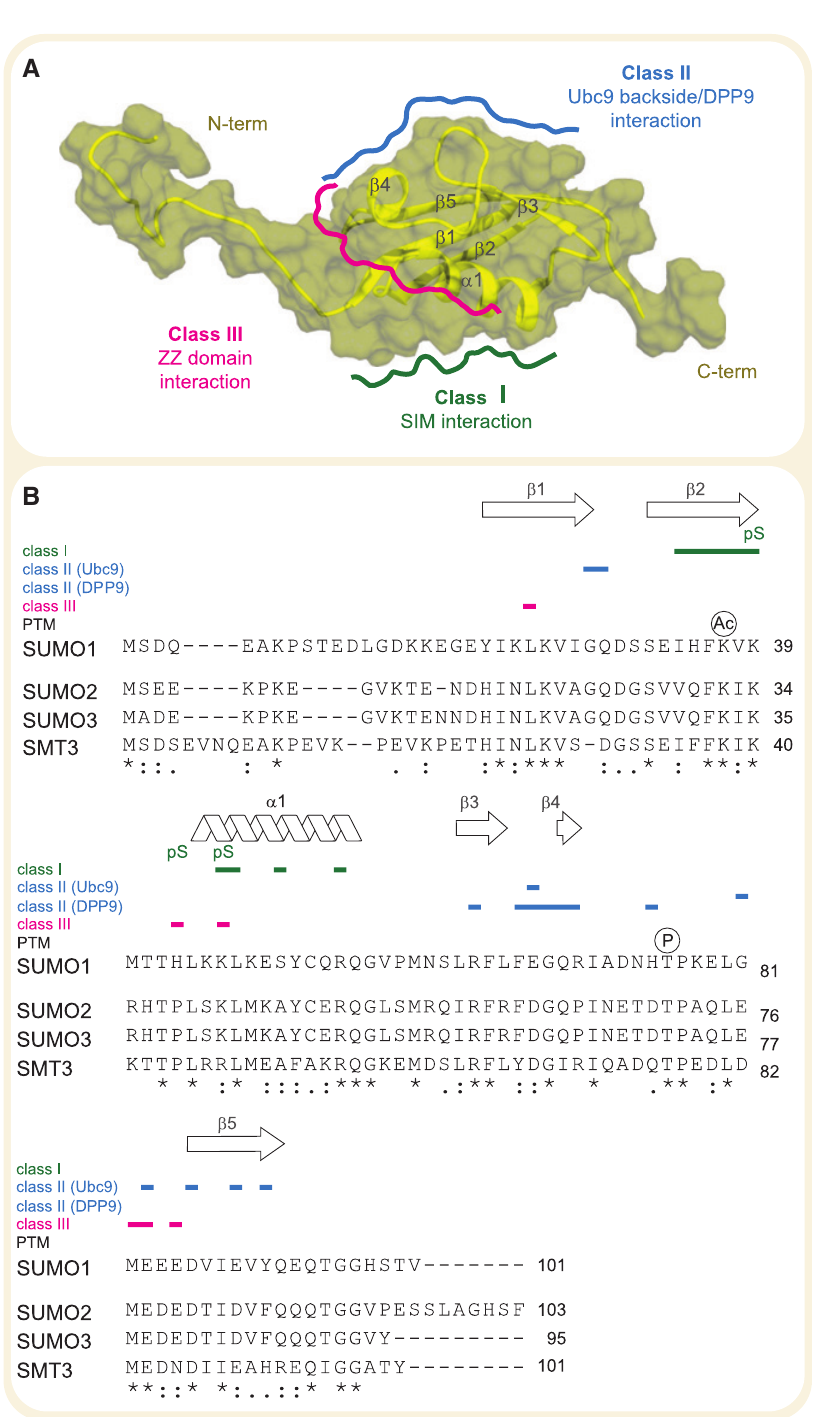
Figure 2: Non-covalent SUMO binding interfaces. (A) Three classes of SUMO interactions are defined by distinct binding interfaces. The surface structure of SUMO1 is shown [yellow, based on 1A5R, (37)] with the classical class I SIM surface [residues I34-K39, K46, L47, S50, R54, (76, 209)] indicated in green, class II SUMO binding in blue [backside of Ubc9 involves G28, Q29, E67, G81, E83, D86, E89, Y91 (72, 77) and DPP9 R63, F66-R70, H75; (80)] and class III ZZ domain interaction in magenta [residues L24, H43, K46, M82, E83, E85; (82)]. N-term and C-term indicate the N- and C-termini of the protein. Secondary structure elements ( α : alpha-helix, β : beta-sheet) are labeled and numbered. (B) A sequence alignment of SUMO1, 2, 3 and Smt3 is shown and the structural features are highlighted. Amino acids involved in the particular interactions based on SUMO1 are marked in the same colors as in (A) and residues that are targets of modifications are indicated as Ac for acetylation and P for phosphoryla- tion. pS demonstrates phospho-SIM